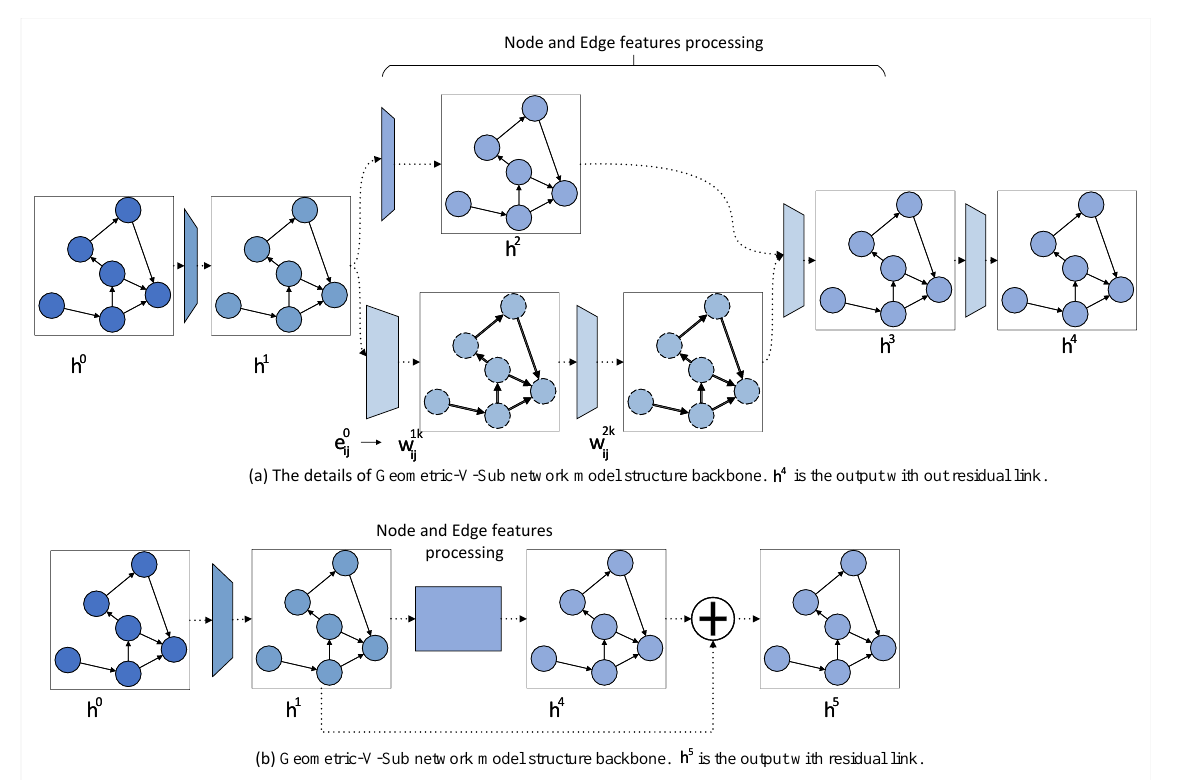
Figure 1. Graph processing flow of structural data through the